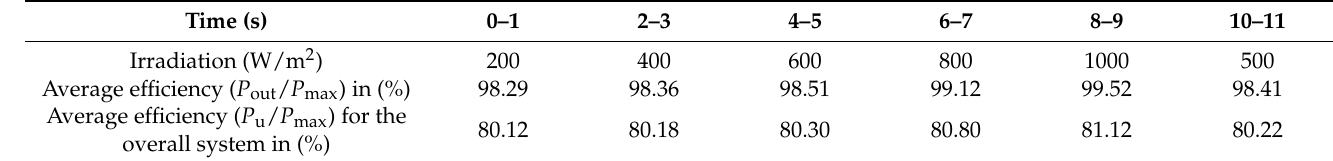
( b ) Figure 12. ( a ) Rotor speed evolution for CDTC and FDTC, and ( b ) water flow for CDTC and FDTC. It can be seen that the proposed FDTC reduces the torque ripples and fluctuations, which consequently improves the pumping system performance and increases its service life. As illustrated by Figure 13b, the suggested FDTC also reduces the flux ripples. More comparison details are provided in Table 6.